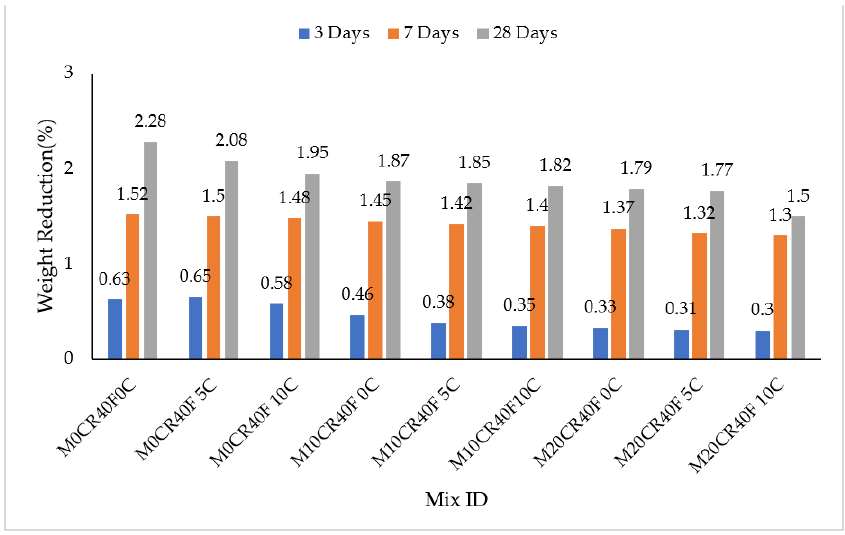
Figure 5. Immersion periods in MgSO 4 for SCC mixes containing fly ash, CR, and CCW.